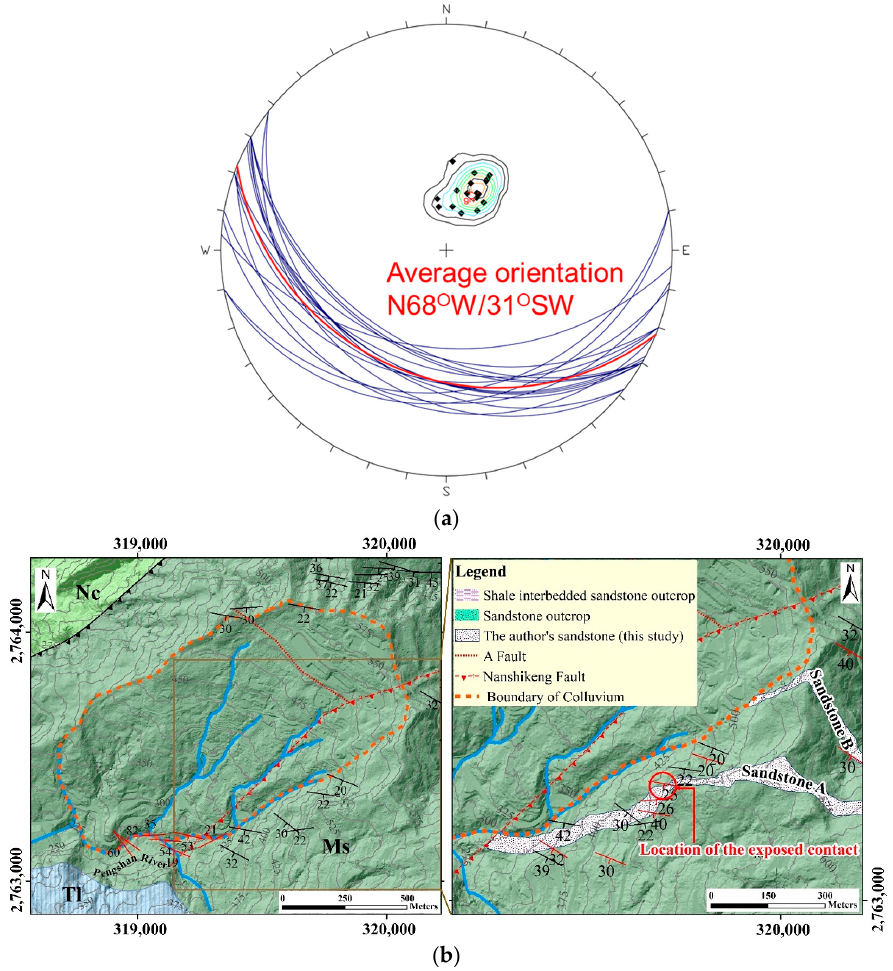
Figure 10. Geological model combining the field exposures and topographical analysis in Zone 3 . ( a ) Stereonet visualization presents the outcrop measurements; and ( b ) outcrops measured during the field survey and redistribution of two sandstone layers in the southeastern part.